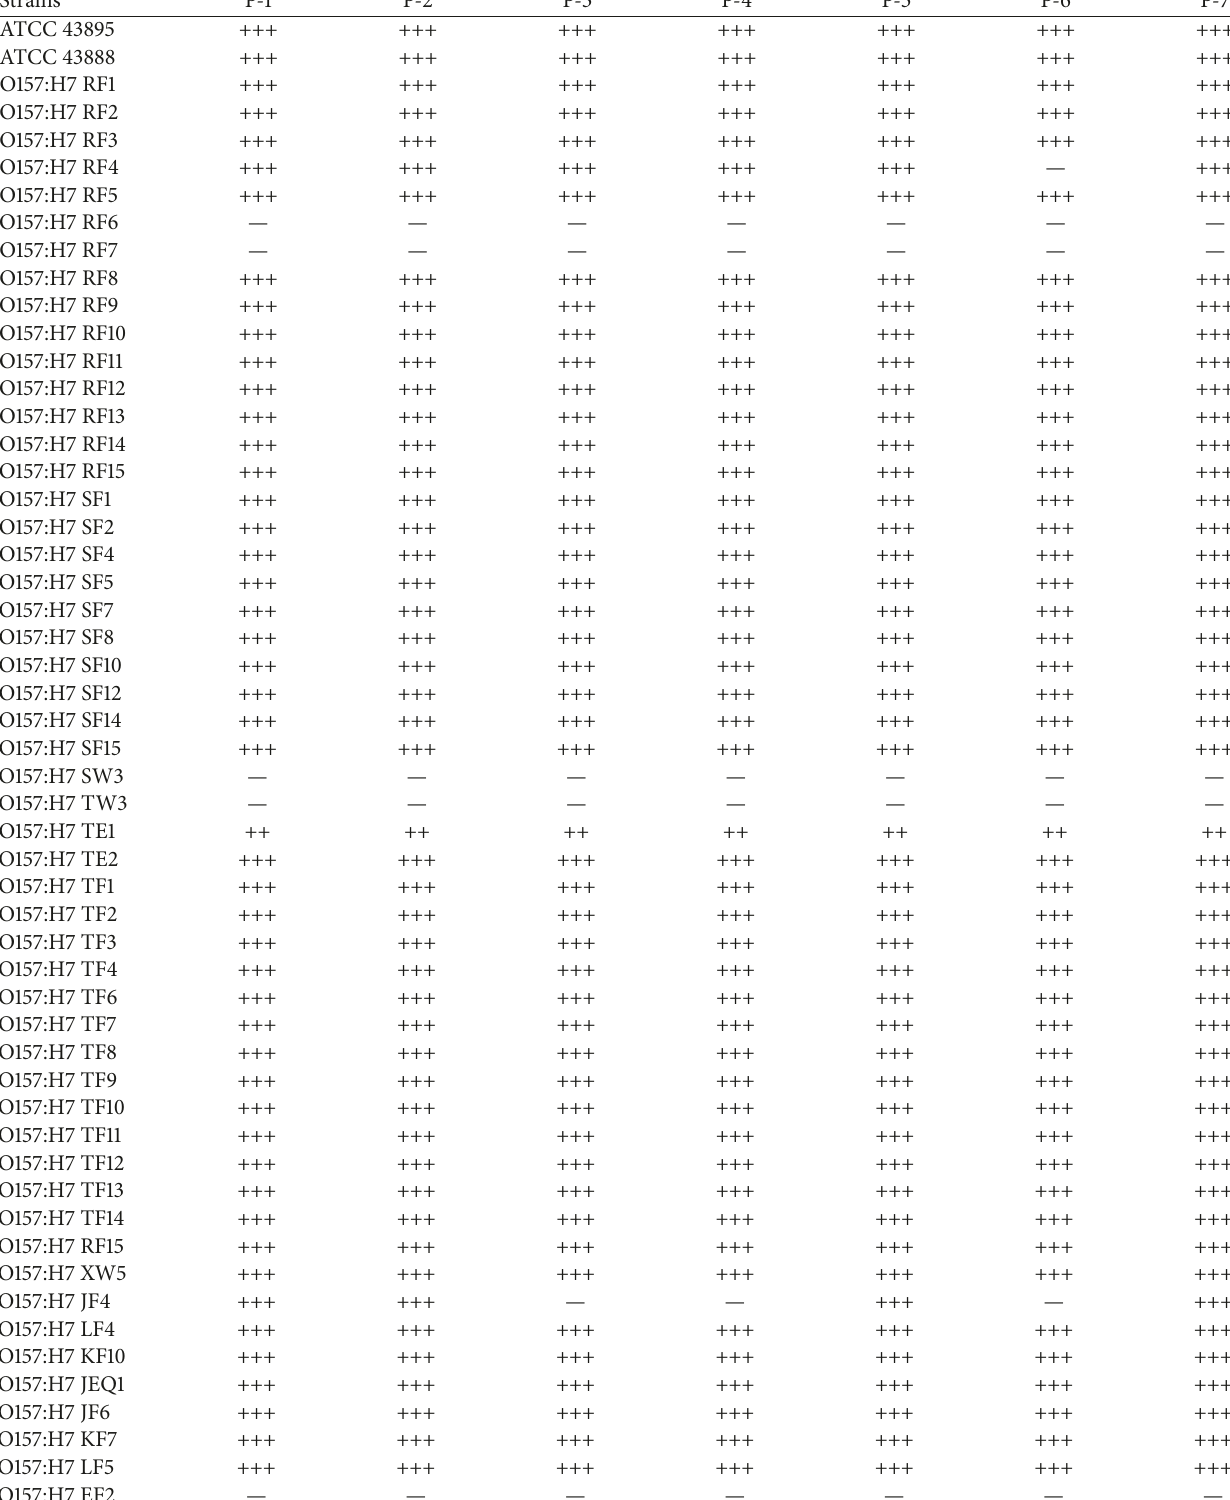
Table 1: Host range ∗ of phages against E. coli O157:H7